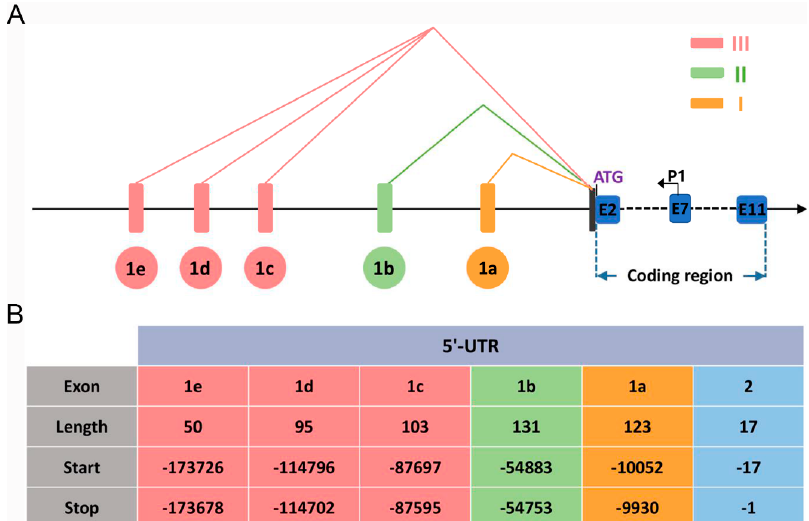
Figure 1. Identification of the transcription start sites of the ovine BMPR1B gene. ( A ) Schematic diagram showing the different 5 ′ -UTRs of the ovine BMPR1B gene. Exons in the 5 ′ -UTR are shown as long boxes and each transcript is represented by polylines. Exons in the coding region are shown as blue boxes. The translation start site is ATG. P1 is the primer used for 5 ′ -RACE assay. ( B ) Characteristics of exons on the 5 ′ -UTR of the ovine BMPR1B gene. Nucleotide numbering is relative to +1 at the initiating ATG codon.